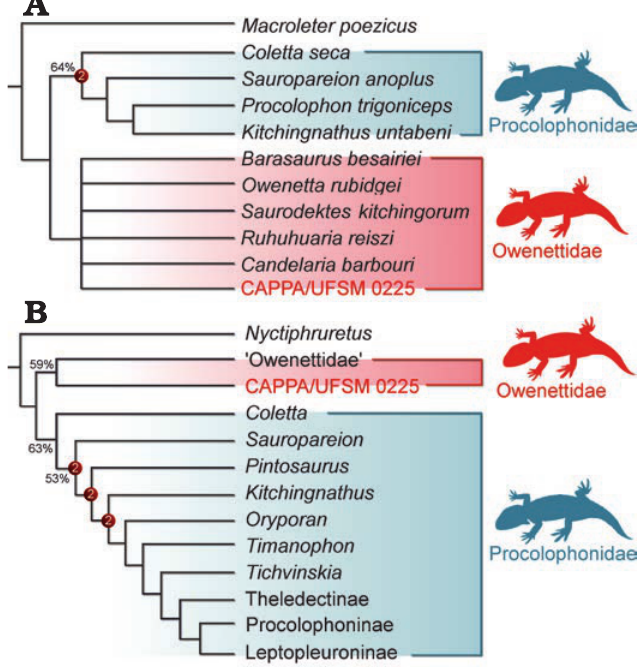
Fig. 4. Results of the phylogenetic analyses. A . Strict consensus tree of the first analysis depicting the phylogenetic position of CAPPA/UFSM 0225. B . Abbreviated strict consensus tree of the second analysis depicting the phylogenetic position of CAPPA/UFSM 0225. Numbers on nodes repre- sent Bremer support values higher than one and Bootstrap values higher than